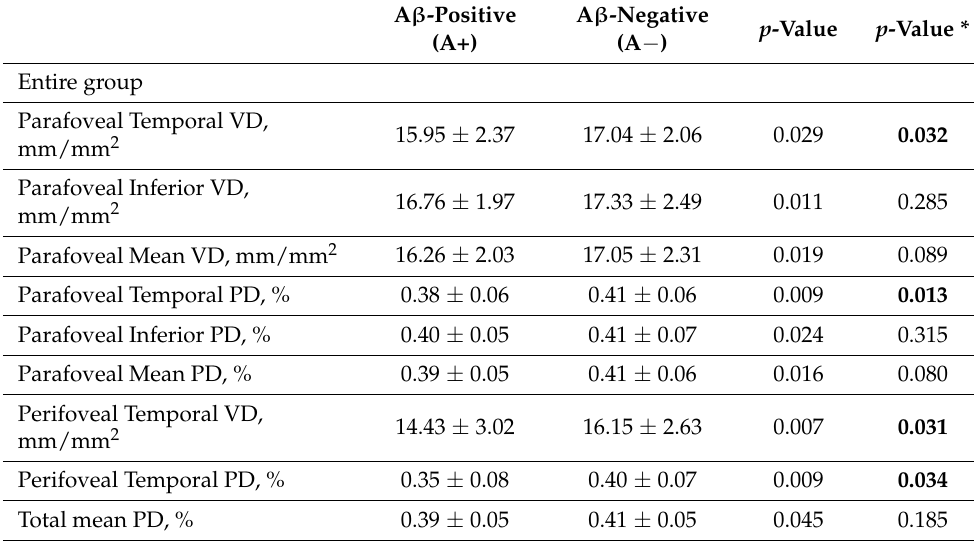
Table 4. Comparison of OCT and OCTA parameters according to A β